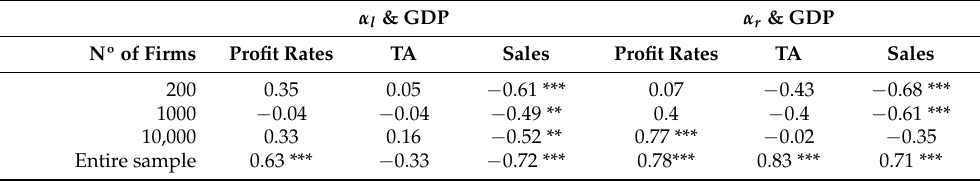
Table 7. Pearson correlation coefficient between the time series of the estimates of α l and α r with the time series of GDP growth rates. *** denotes significance at the 1% level; ** denotes significance at the 5% level; * denotes significance at the 10%